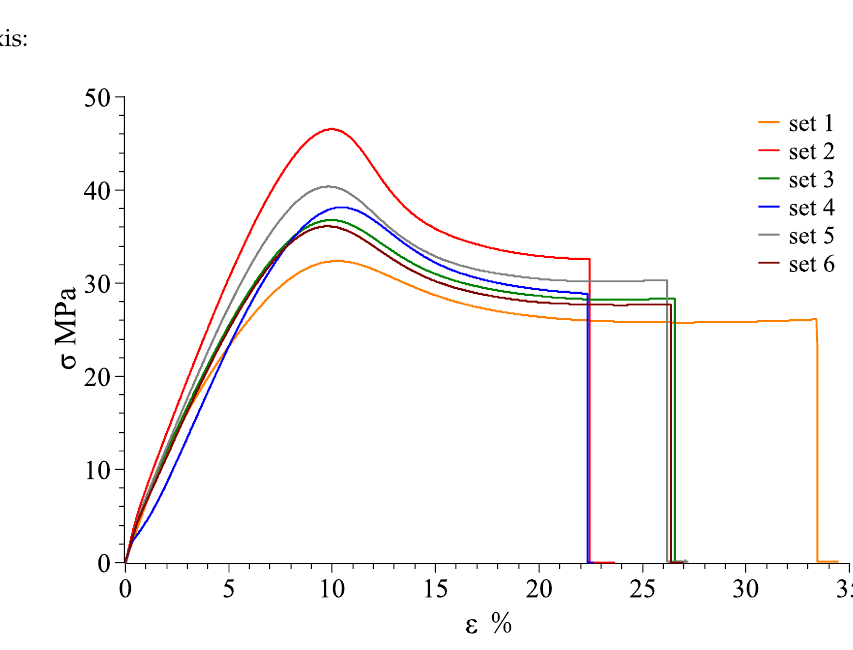
Figure A2. D8510, D8520 stress–strain curve for the Y-axis (6 specimens).